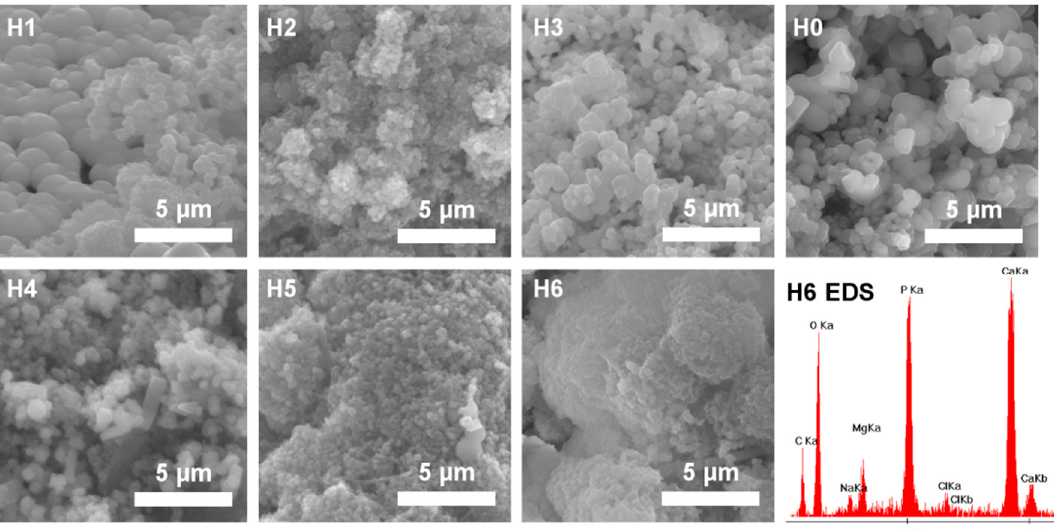
Figure 12. SEM (scanning electron microscopy) images of the hydrogels surface (H0: chitosan (CS); H1: CS / graphene oxide (GO); H2: CS / poly(ethylene glycol) grafted graphene oxide (GO-PEG); H3: CS / reduced graphene oxide (rGO); H4: CS / GO / hydroxyapatite (HAp); H5: CS / GO-PEG / HAp; H6: CS / rGO / HAp) after 4 weeks of incubation in simulated body fluid (SBF) solution and representative energy dispersive spectroscopy (EDS) spectrum (for H6).